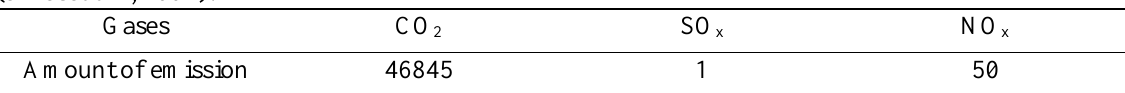
Table 4. Pollutant emissions through gas consumption of residential buildings in Tehran (gr/GJ) (Ghiaseddin, 2007)